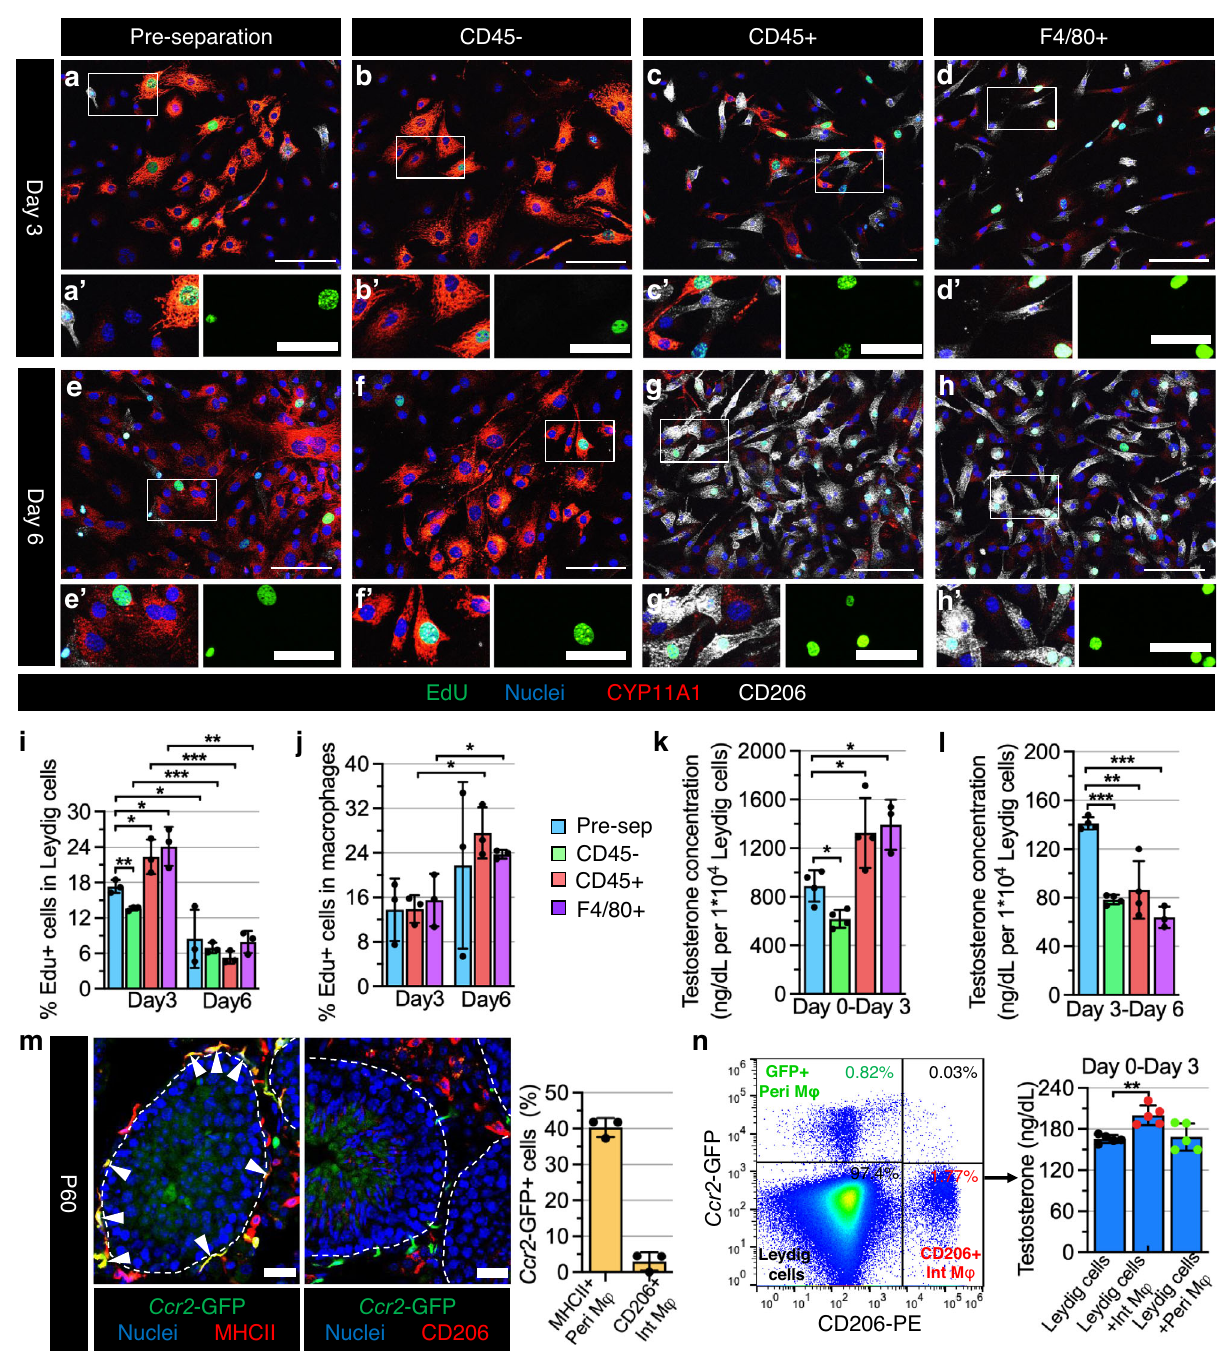
Fig. 7 | Adult interstitial macrophages promote Leydig cell proliferation and steroidogenesis. a – h Representative images ( n =3 independent experiments) of primary cell culture after 3 days ( a – d ) and 6 days ( e – h ) from adult (3-month-old) C57BL/6J testes for pre-separation ( a , e ), CD45-depleted ( b , f ), CD45-enriched ( c , g ), and F4/80-enriched ( d , h ) populations. i – l Graphs showing quanti fi cation ( n =3 independent experiments from 6 testes) of percent EdU + Leydig cells ( i ), percent EdU + macrophages ( j ), and testosterone concentration ( n =4 independent experiments from 8 testes) in culture media after 0 – 3 days of culture ( k ) and 3 – 6 days ofculture( l ) in the 4 different cell populations. m Representative images of Ccr2 GFP/+ testes and graph showing quanti fi cation ( n =3 independent testes) of percent GFP-expressing interstitial (CD206 + ) and peritubular (MHCII +